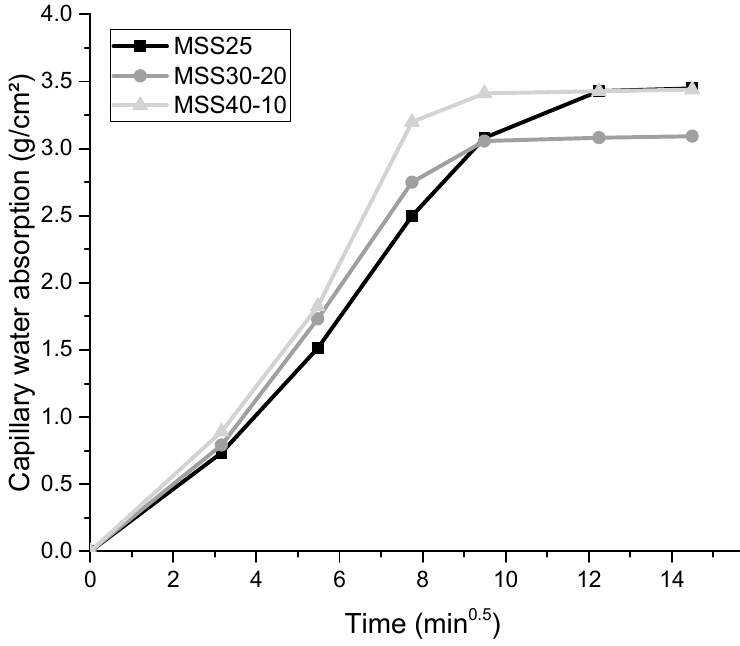
Figure 5. Capillary water absorption of hardened mortars.